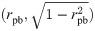
Projective spaces for the representation of point-biserial correlation.The point-biserial correlation coefficient, rpb, corresponds to the point (rpb,1-rpb2) on the positive half-circle, S+1, and the point (pApBd,1) on the projective line, P1. The homogeneous coordinates (pApBd,1)t for t∈R1 correspond to points on the line through the origin. {pA, pB}: sample size proportions, d: Cohen’s d.